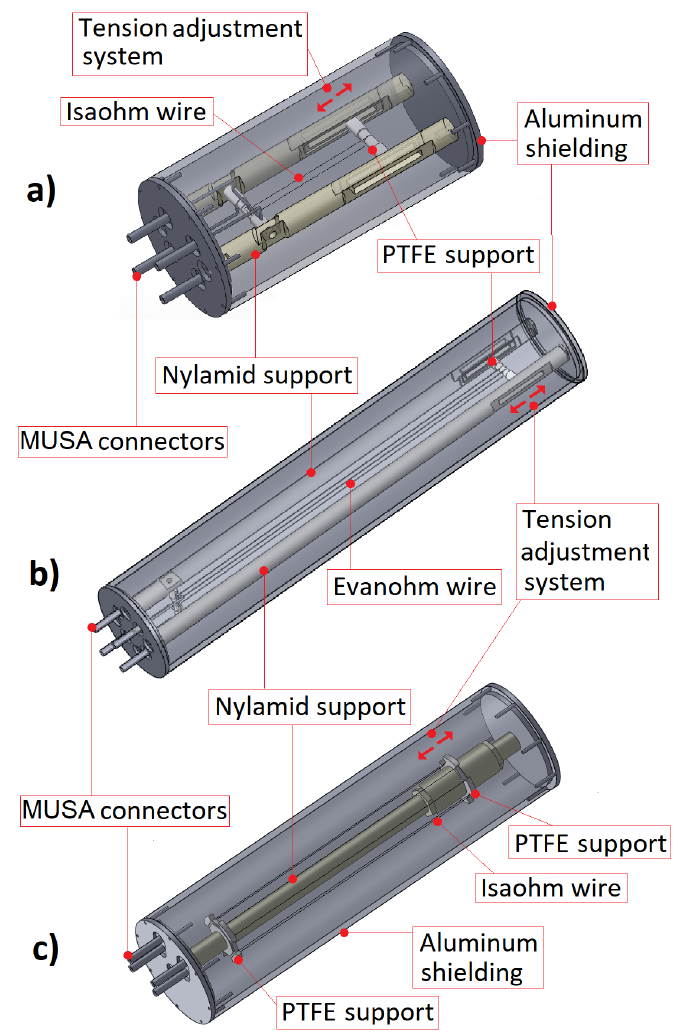
Figure 1. Assembly of CR pieces of: ( a ) 1 k Ω bifilar, ( b ) 1 k Ω quadrifilar, and ( c ) 10 k Ω